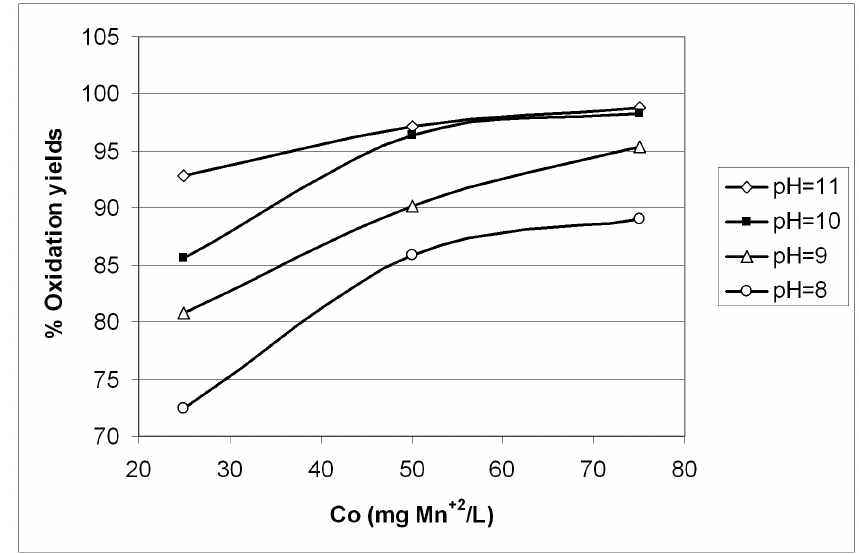
Fig. 5 Oxidation yields as a function of pH and concentration (20 ◦ C, solution with glass beads and 0.5 g